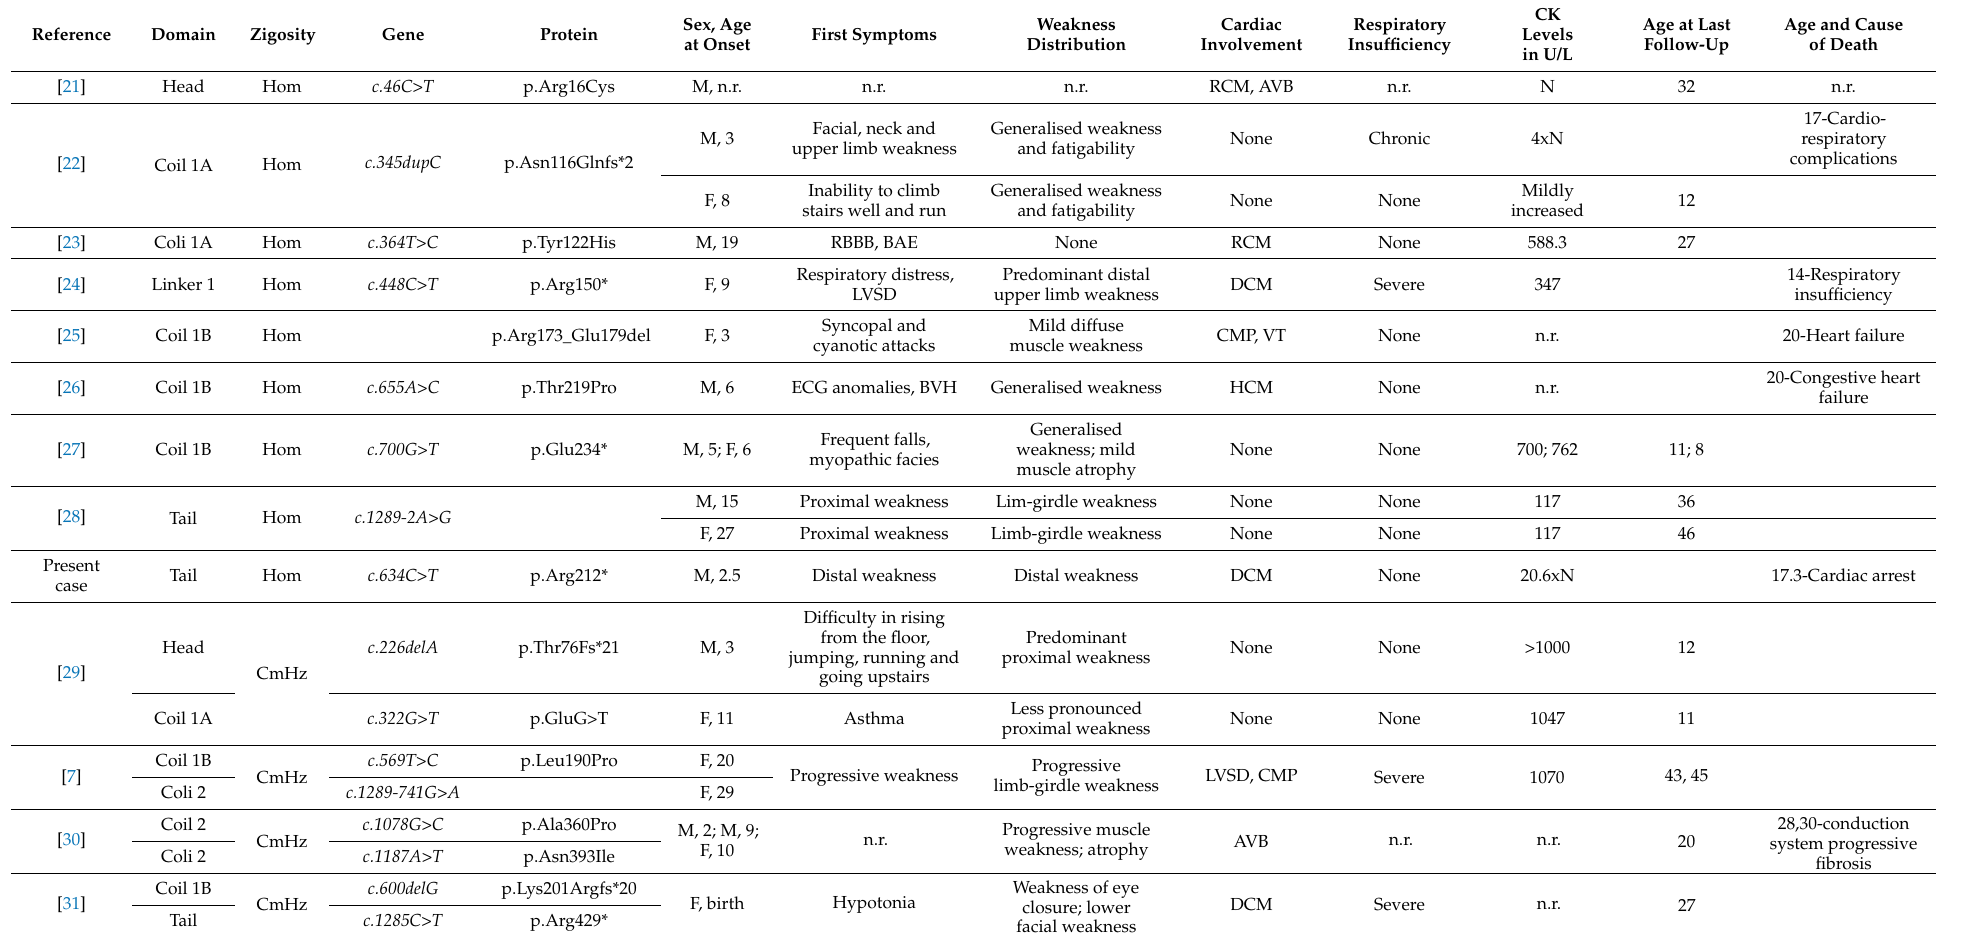
Table 1. Human recessive desmin mutations and related